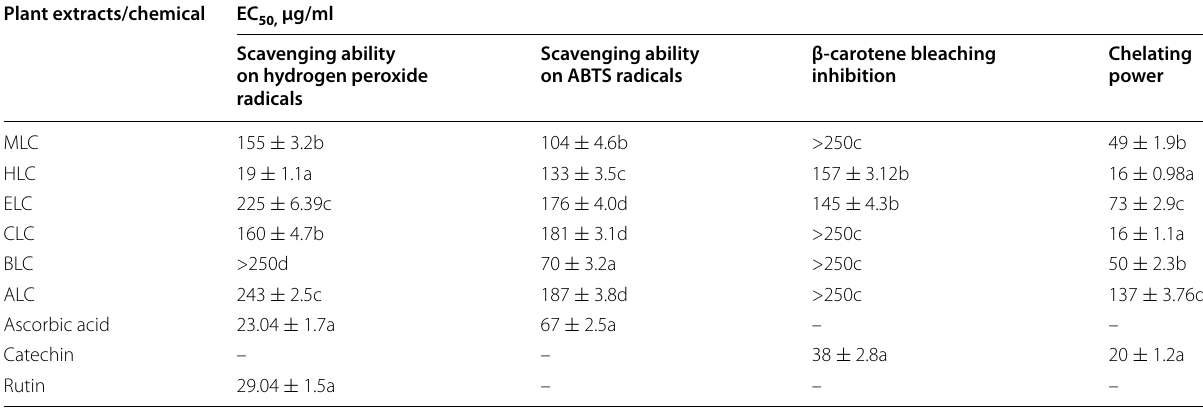
–, Not determined Each value in the table is represented as mean Values in the same column followed by a different letter are significantly different (p < 0.05)